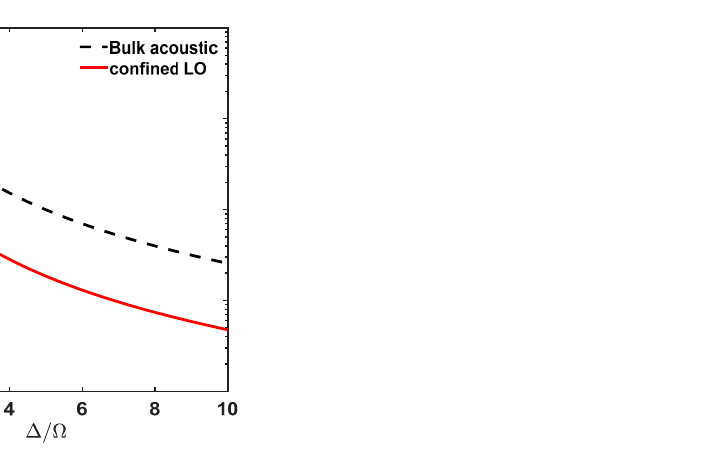
Figure 4. Phonon assisted transition rate between the dressed state for GaAs QD of radius 3.39 nm at T = 1 K. (Red line: confined LO phonon n = 1 mode contribution to transition rate, Black line (dashed): bulk acoustic phonon contribution to transition rate).